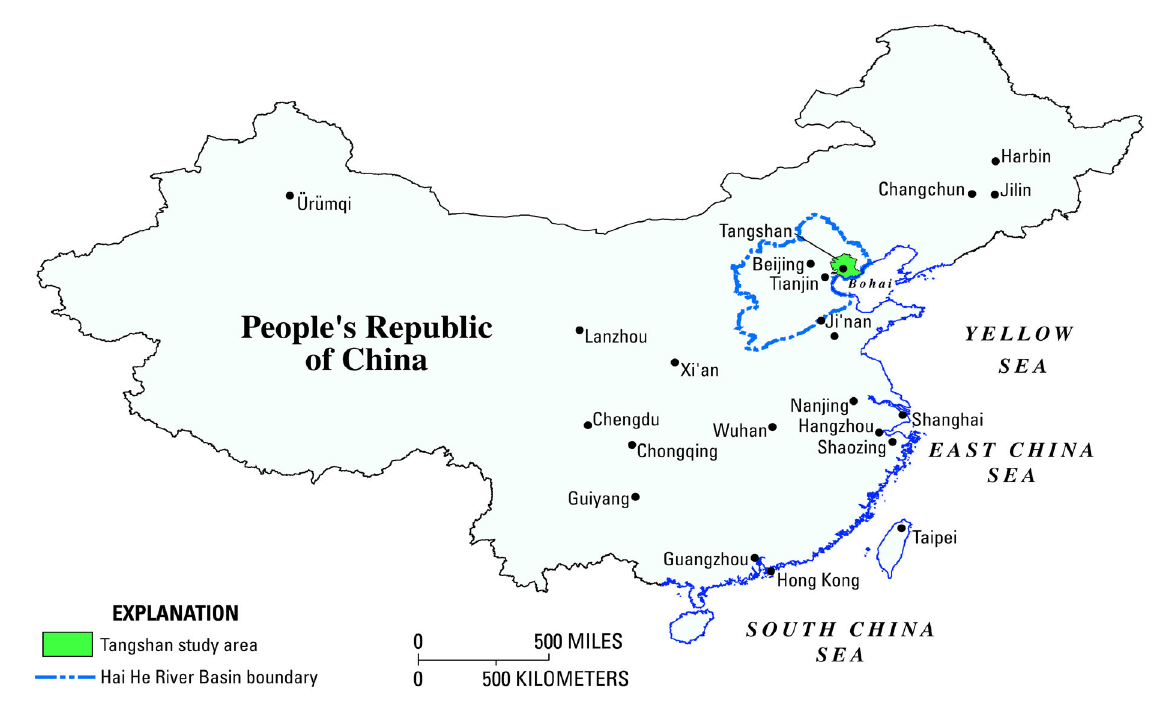
FIGURE 1. Map of People’s Republic of China showing the Hai He River Basin and the Tangshan study